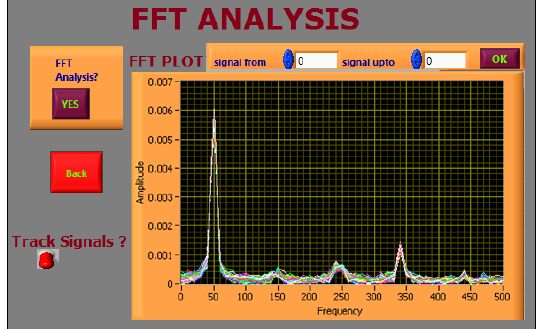
Figure 18. LabVIEW FFT based frequency domain analysis in the front panel.